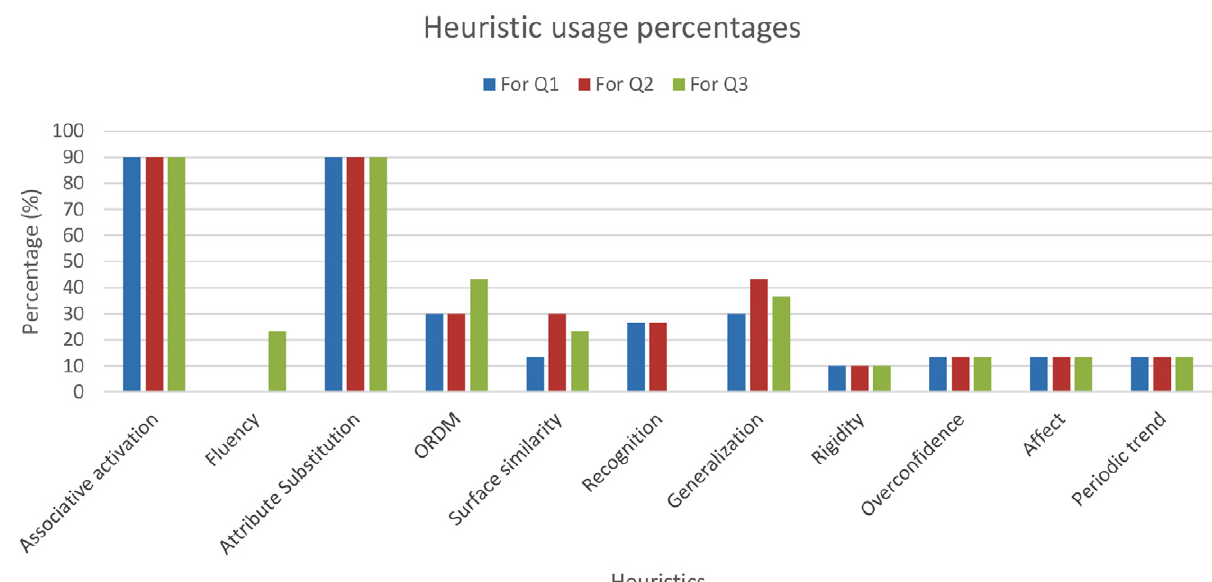
Figure 1. Graphical presentation of heuristic usage